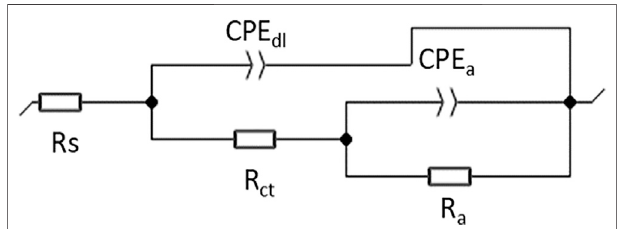
FIGURE 6 | Equivalent electrical circuit